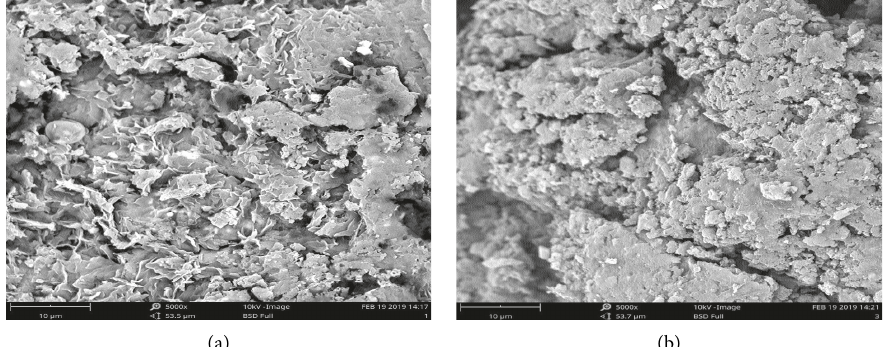
Figure 9: SEM images of the (a) Coir filter media and (b) Areca Husk bio materials after the